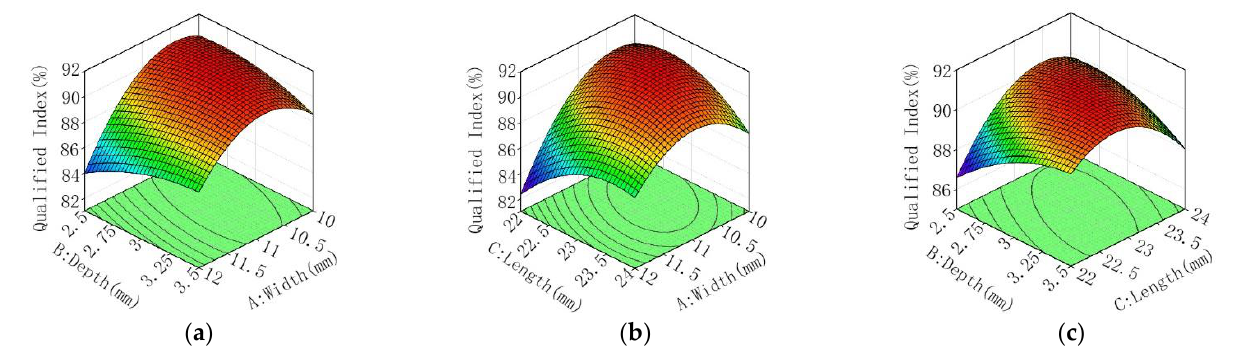
Figure 14. The impacts of interaction factors on the qualified index. (a). AB Interaction; (b). AC Interaction; (c). BC Interaction. ( c ). BC